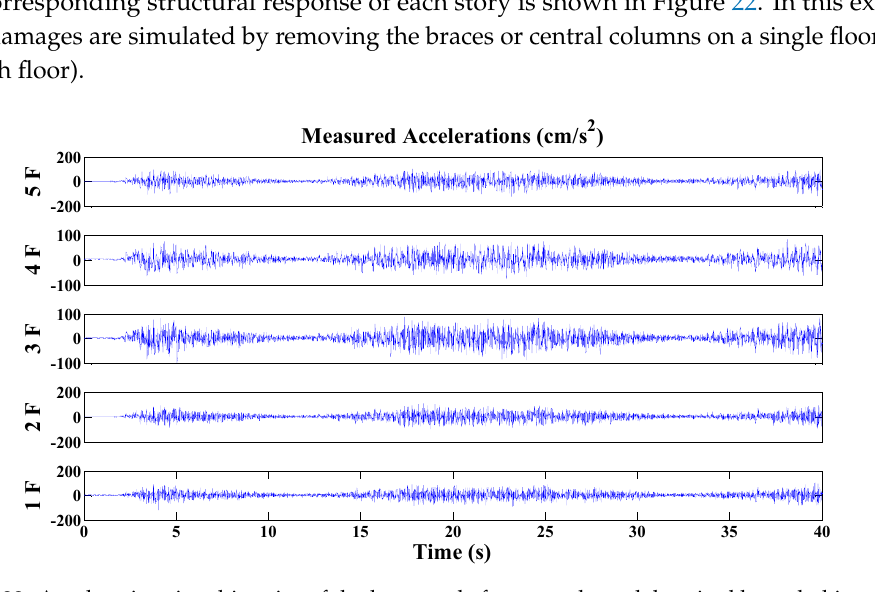
Figure 23. Damage cases: removing braces on the ( a ) first; ( b ) third; and ( c ) fifth story. Figure 24. Damage cases: removing central column on the ( a ) first; ( b ) third; and ( c ) fifth story.